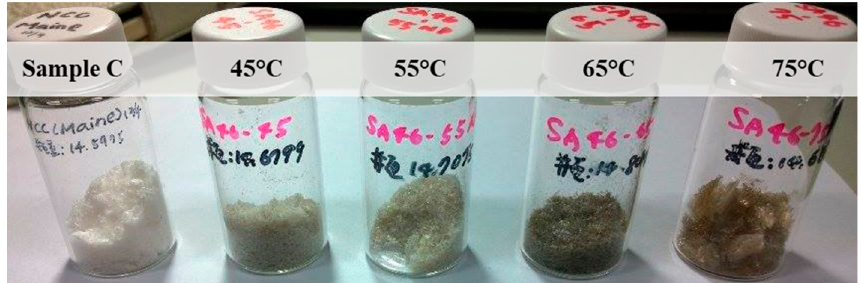
Figure 3. P-CNCs prepared at different hydrolysis temperatures—45, 55, 65, and 75 °C from left to right—compared with the standard (sample C).